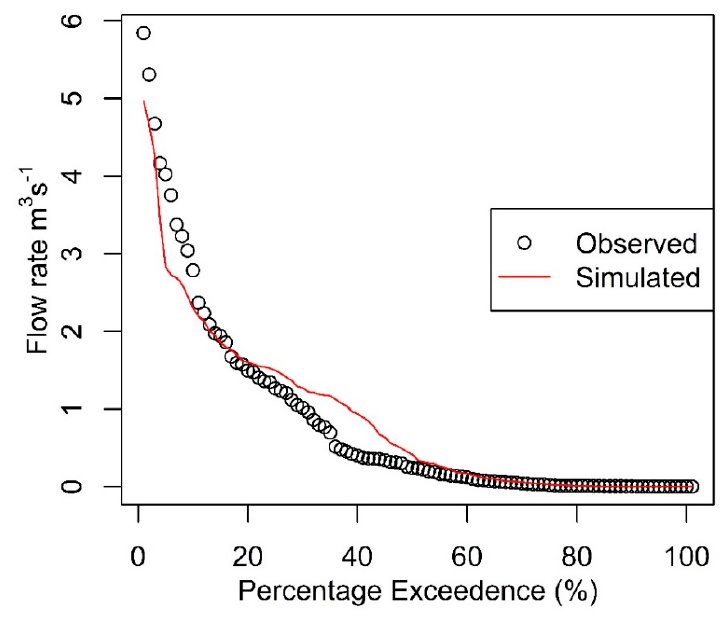
Figure 3. Flow duration curve at the gauge station after first step calibration.